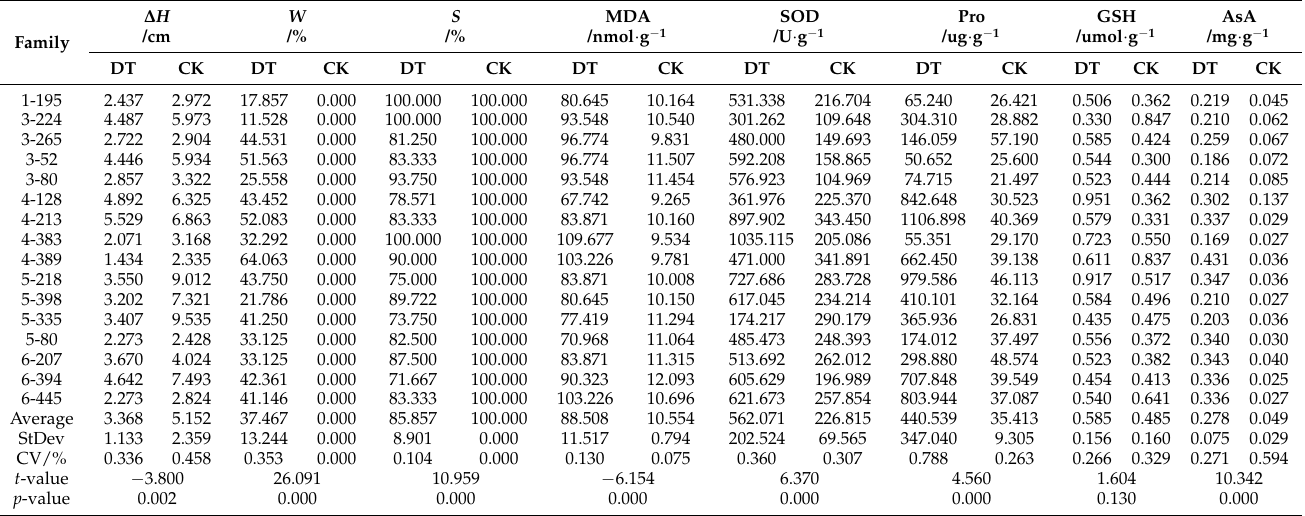
Table 3. Measurements of indices under drought stress and normal conditions.